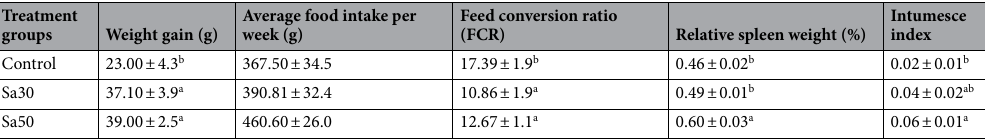
Table 2. Growth performance of rats, relative spleen weight and intumesce index of the groups fed Nigella sativa seeds (30 and 50 g/kg) and the control group. The data are presented as the means ± SEs, n = 6 per group. Means within the same column with different superscript letters are significantly ( P < 0.05) different according to one-way ANOVA followed by Duncan’s post hoc analysis . Sa30: group fed Nigella sativa at 30 g/kg diet; Sa50: group fed Nigella sativa at 30 g/kg diet.